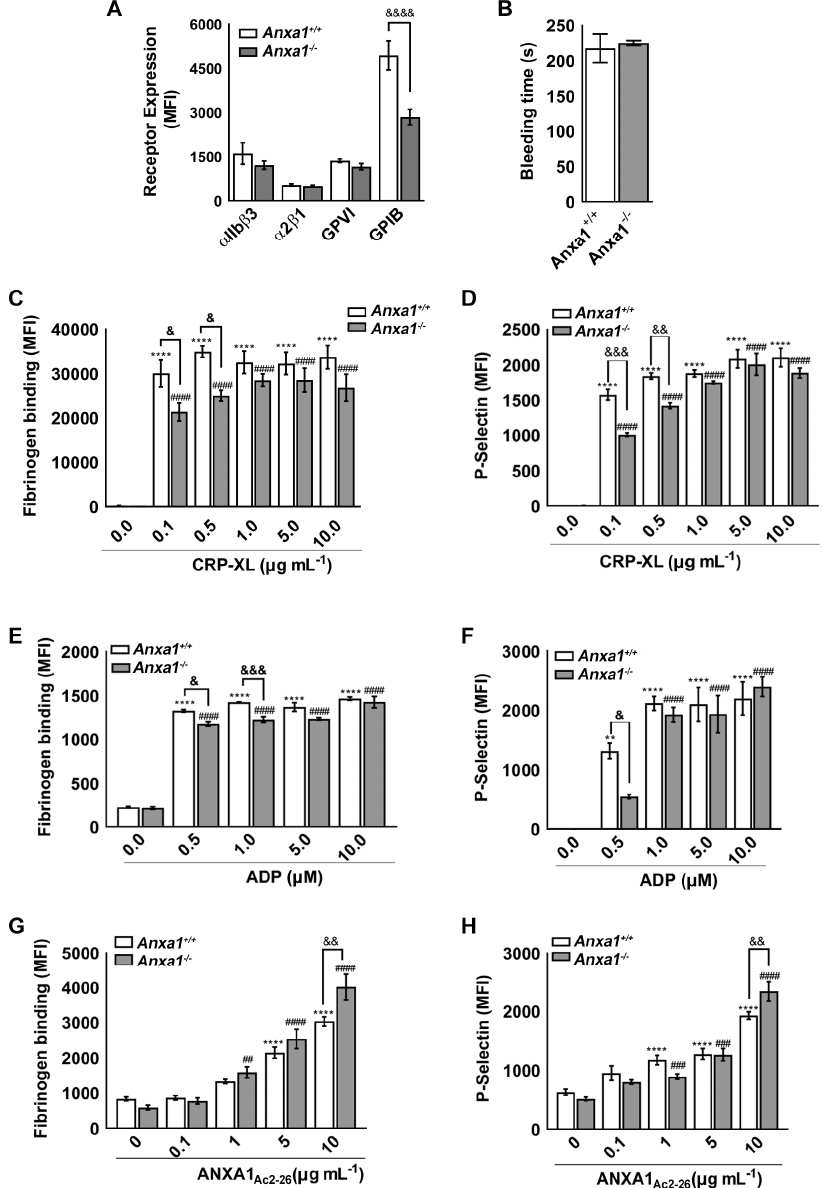
Figure 1. The characterisation and reactivity of platelets obtained from Anxa1 − / − mice. ( A ) The expression of major receptors was analysed in platelets (whole blood) obtained from the control and Anxa1 − / − mice using fluorescently labelled antibodies for specific receptors by flow cytometry. ( B ) Tail bleeding time in control and Anxa1 − / − mice following the dissection of 3 mm tail tip. The amount of fibrinogen binding and exposure of P-selectin in platelets from the control and Anxa1 − / − mice upon treatment with different concentrations of CRP-XL ( C , D ), ADP ( E , F ), and ANXA1 Ac2-26 ( G , H ) were analysed using fluorescent-labelled anti-fibrinogen and P-selectin antibodies by flow cytometry. Data represent mean ± S.D. Statistical analysis was carried out using a two-way ANOVA test followed by Sidak’s multiple comparison tests ( A ) ( n = 4 for each animal group), non-parametric Mann–Whitney test ( B ) ( n = 7 for each animal group), two-way ANOVA for repeated measures with Tukey’s multiple comparisons test for ( C – H ) ( n = 4 for each animal group). * p < 0.05 ** p < 0.01, *** p < 0.001 and **** p < 0.0001 (same applies to # and & symbols); ‘*’ and ‘#’ represent the comparison between the treated and untreated samples in the relevant mice group; ‘&’ represents the comparison between the control and Anxa1 − / − mice in relevant data